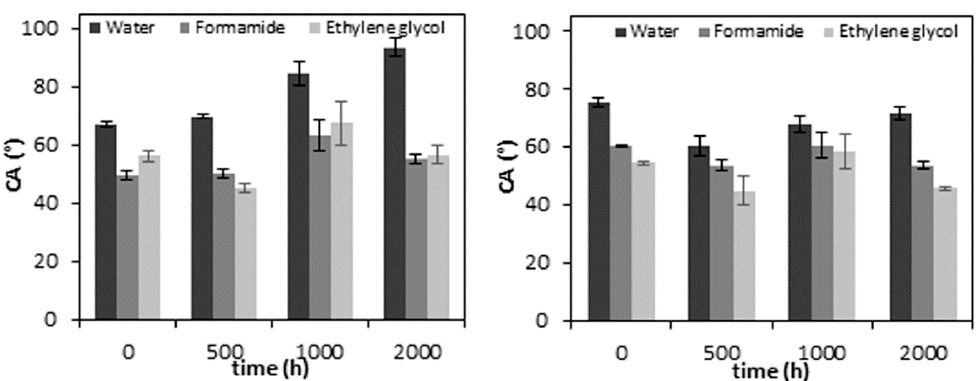
Figure 7. CAs of water, formamide and ethylene glycol in neat PLA (left) and PLA/TiO 2 (right) as a function of increasing weathering exposure time.